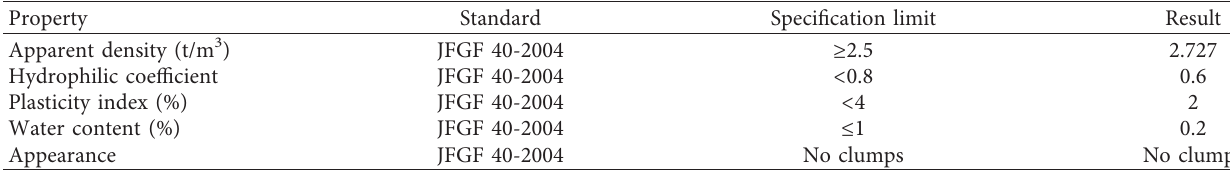
Table 4: Physical properties of the filler.